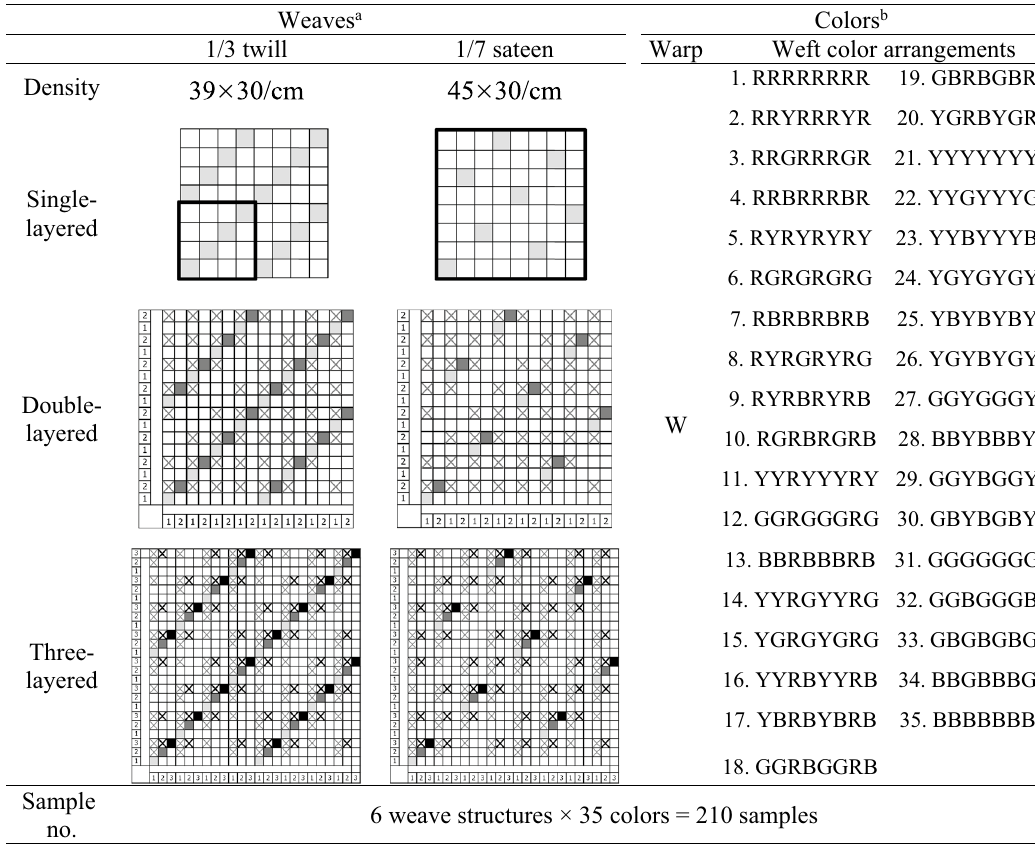
Table 1. Designs of single-, double-, and three-layered woven fabric samples. a Weaves. In the images of single- layered samples, a bold box indicates a weave repeat. In the images of double- and three-layered samples, the mark X indicates a stitching point. b Colors. The warp color, white, and 35 weft color arrangements were used for single-layered samples and all layers in double- and three-layered samples identically. W = white yarn; R = red yarn; Y = yellow yarn; G = green yarn; B = blue yarn.